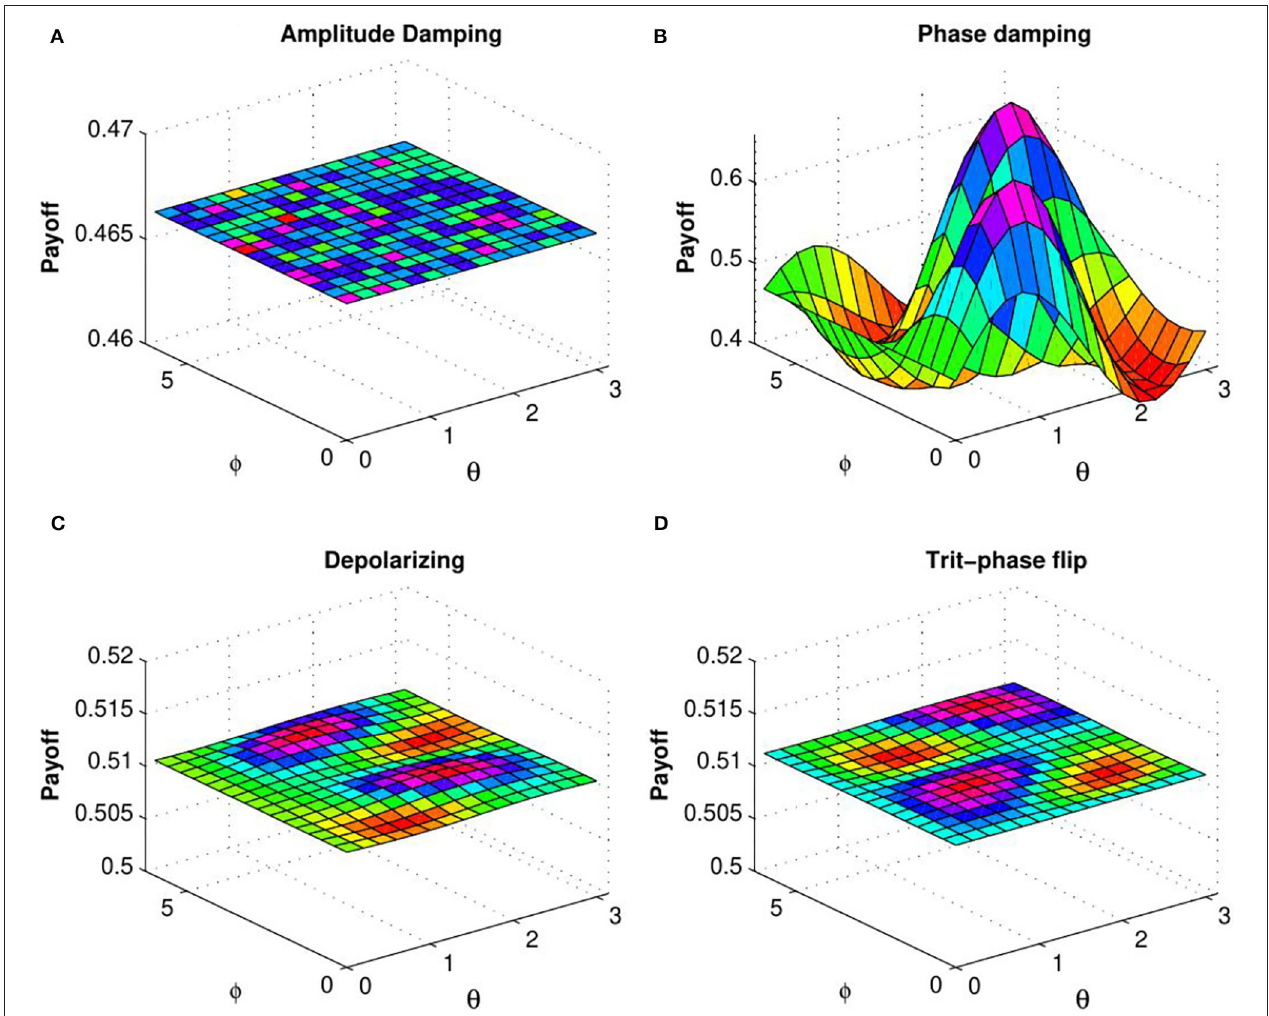
FIGURE 6 | (Color online) Plot of Alice’s expected payoff as a function of θ and φ [determined by Equation (25)] for (A) amplitude damping, (B) phase damping, (C) depolarizing, and (D) trit-phase flip channels with decoherence parameter p